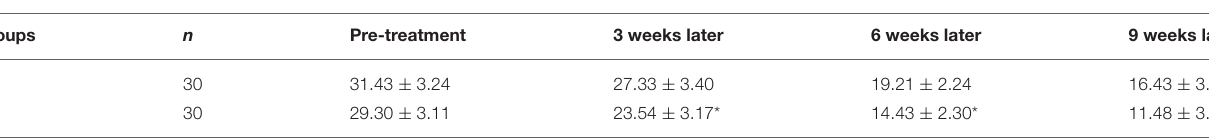
TABLE 4 | Comparison of Hamilton Depression Scale scores.